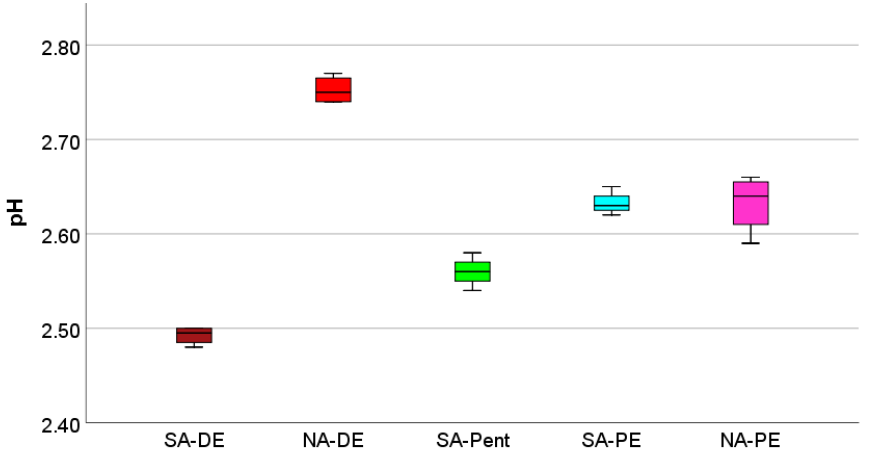
Figure 7. pH of the water after foam leaching. Polymers 2019 , 11 , x FOR PEER REVIEW